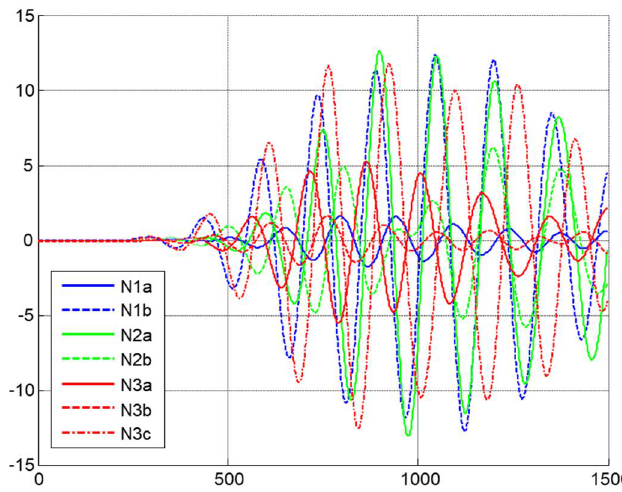
Figure 4. Received A-scans in studied geometries.